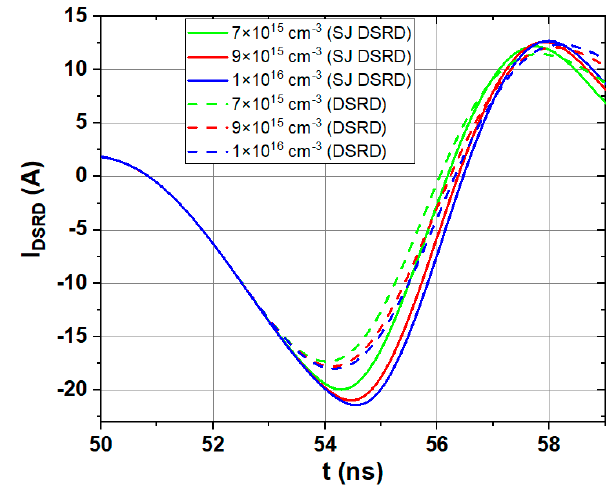
Figure 9. Current waveforms of conventional SiC DSRD and SJ SiC DSRD with N nb of 7 × 10 15 cm − 3 , 9 × 10 15 cm − 3 , and 1 × 10 16 cm − 3 . ( T nb of 10 μ m, the same circuit conditions) Table 3. Comparison of output pulse parameters of conventional SiC DSRD and SJ SiC DSRD with N nb of 7 × 10 15 cm − 3 , 9 × 10 15 cm − 3 , and 1 × 10 16 cm − 3 . ( T nb of 10 μ m, the same circuit conditions).